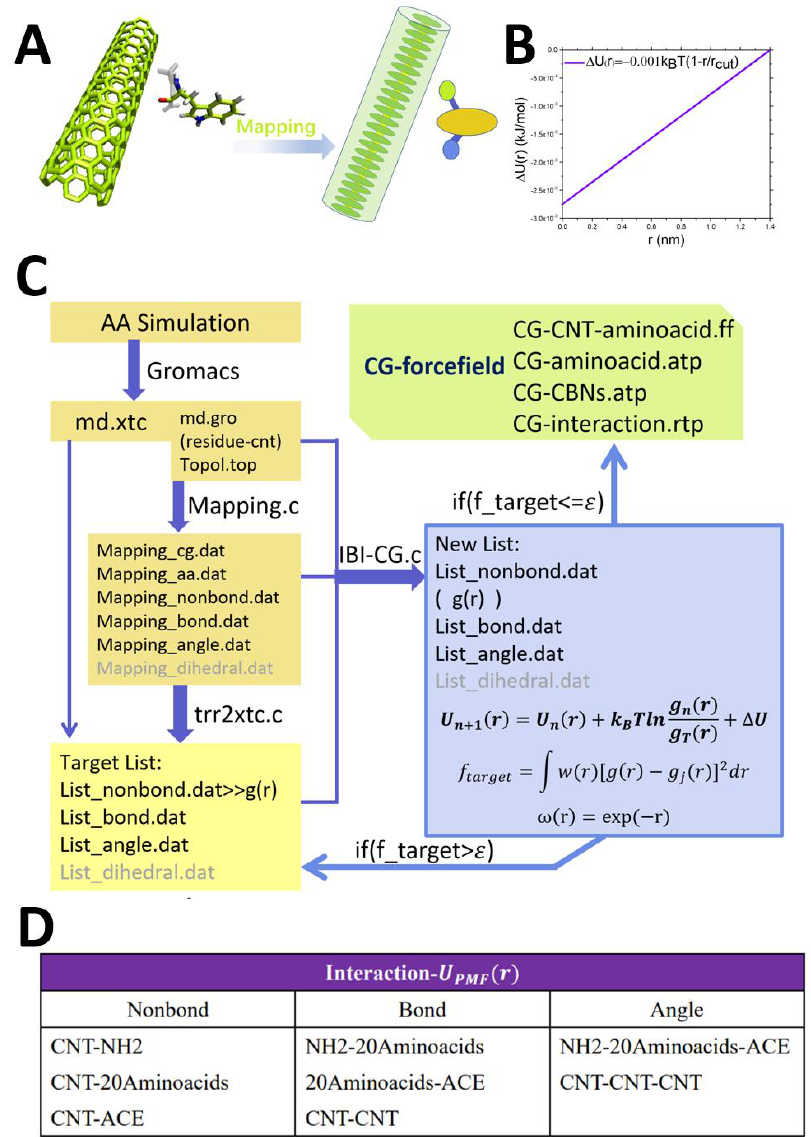
Figure 2. ( A ) Schematic diagram of the coarse-grained method of the simulation system Mapping: (1) CNT part: 10 AAbeads are coarse-grained into one CGbead, 24 CNT-CGbeads in total; (2) Amino acids Part: An amino acid molecule is coarse-grained into one CGbead. Mapping the main chain and side chain of the amino acid to one CGbead. ( B ) Linear addition function. ( C ) Detailed flow chart of IBI-20Aminoacids-CNT55L3, including the interaction process of each file. ( D ) Table: list of the average field potential energy of each initial interaction relationship.